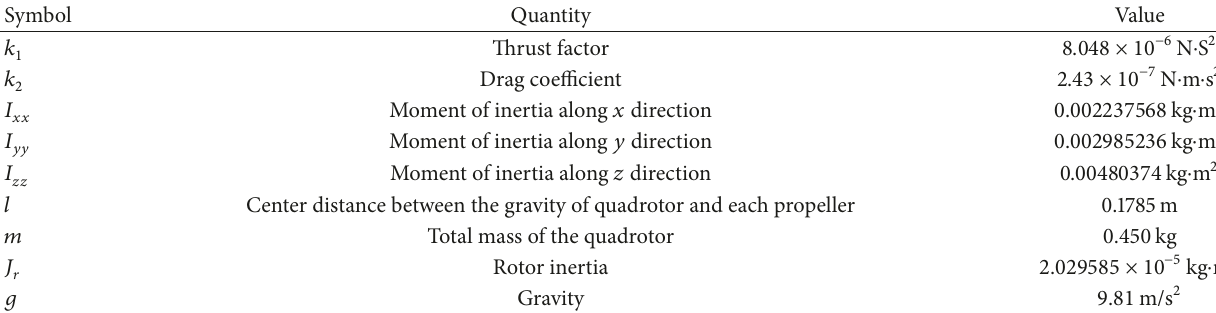
Table 1: Quadrotor parameters.